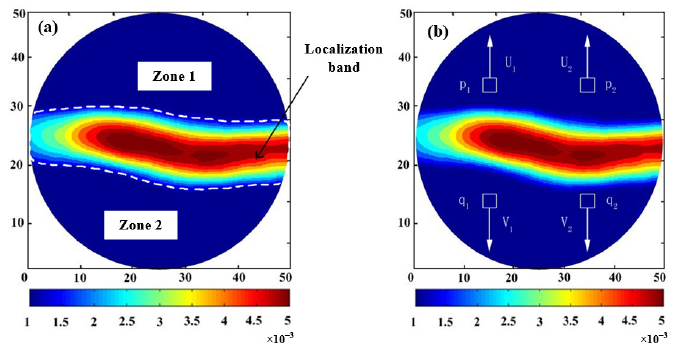
Figure 16. Characteristics of deformation localization zone of coal with outburst proneness. ( a ) Schematic diagram of energy analysis area. ( b ) Relative tensile displacement.